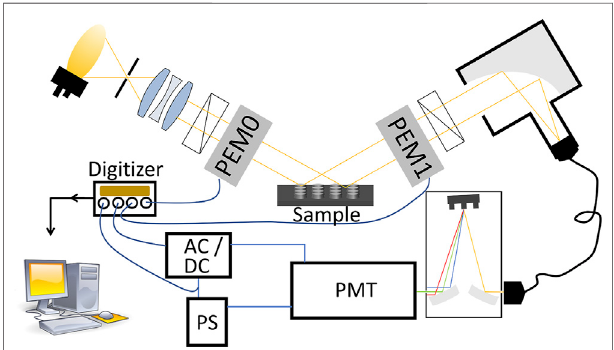
FIGURE 2 | Schematic illustration of the experimental setup. The main componentsarethelightsource,thetwophotoelasticmodulators(PEM0and PEM1), a monochromator and a detection system based on a photomultiplier tube (PMT), a high voltage power supply (PS) and electronics measuring the AC and DC components of the signal